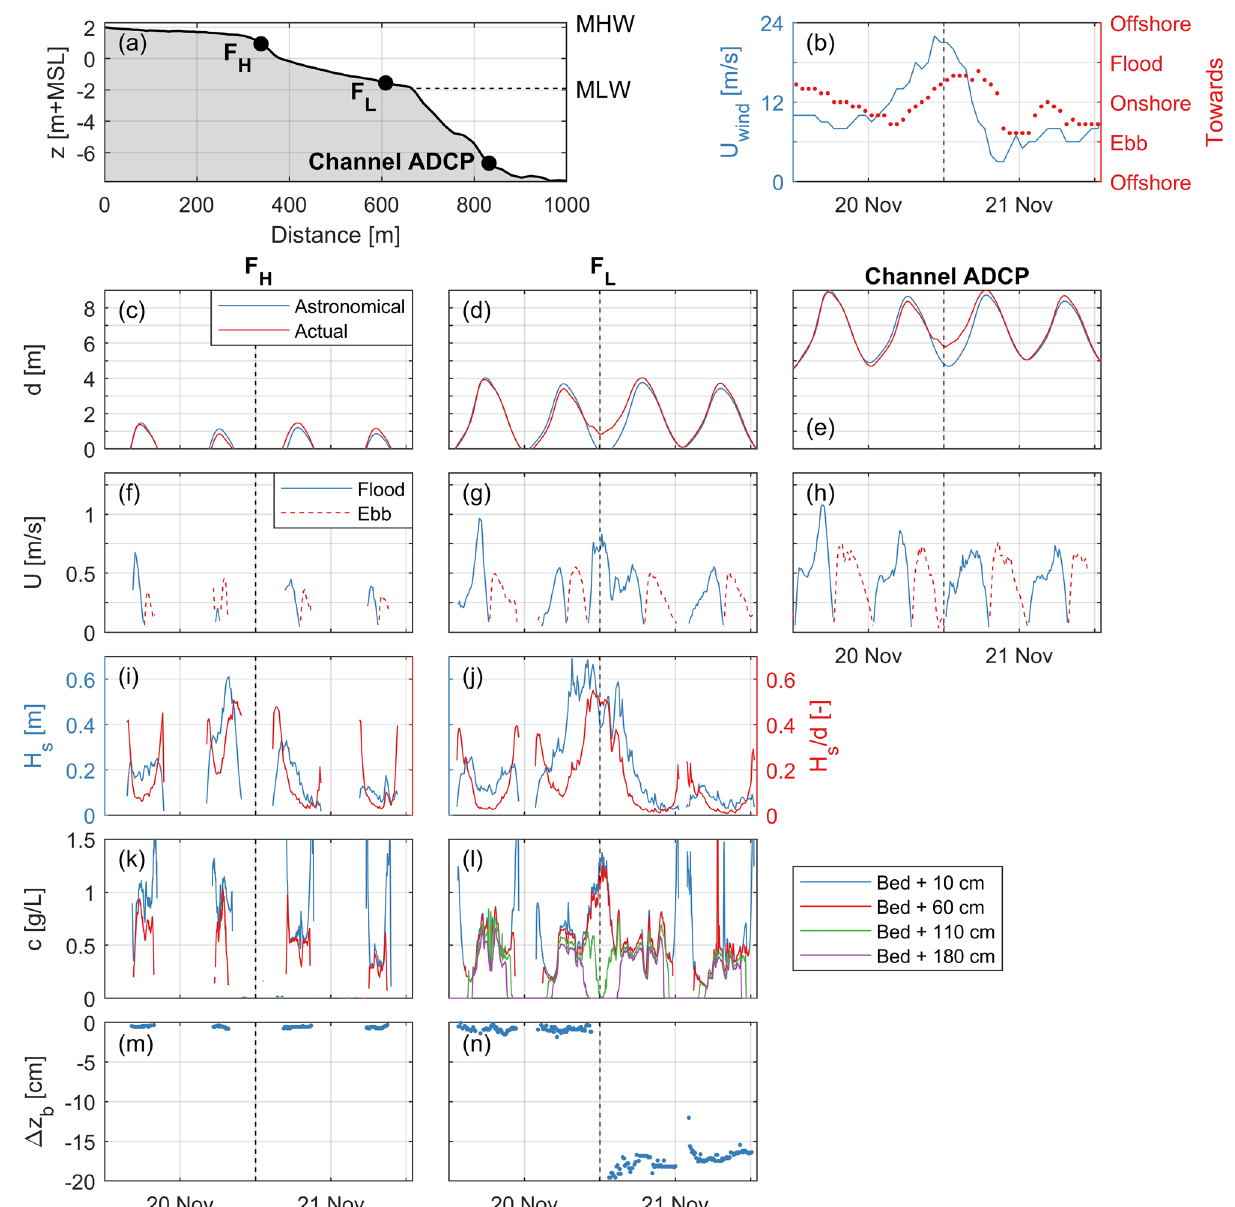
Figure 4. Process measurements for four tides along a storm event in 2016 on the Zuidgors intertidal flat (Western Scheldt). ( a ) Measurement stations (see Fig. 1a for the location of the transect). ( b ) Hourly-averaged wind speeds and directions at Vlissingen meteorological station (location in Fig. 1). ( c )–( e ) Water depths, including the derived astronomical water depths (the difference is the storm surge). ( f )–( h ) Flow velocity magnitudes (flood and ebb directions indicated in Fig. 1). ( i , j ) Significant wave heights (the wave logger of F H was positioned 50 m downslope), including the significant wave height over depth ratio. ( k , l ) Suspended sediment concentrations at various distances from the bed. ( m , n ) Bed level changes relative to the initial elevations. The vertical black dashed lines indicate the peak of the storm. All time series are in CET